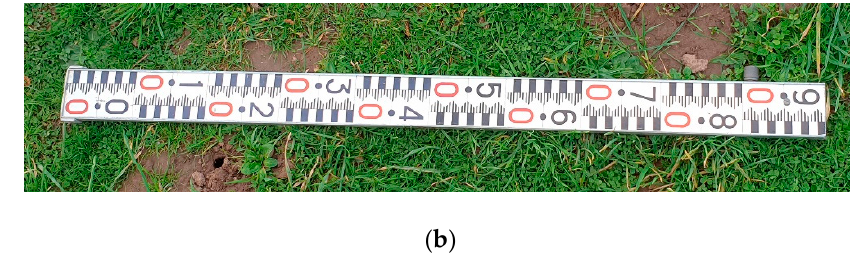
Figure 5. ( a ) Target applied for the photogrammetric support. ( b ) Stadia. The location of the support (targets) and control elements (stadias) are shown in Fig- ure 6.